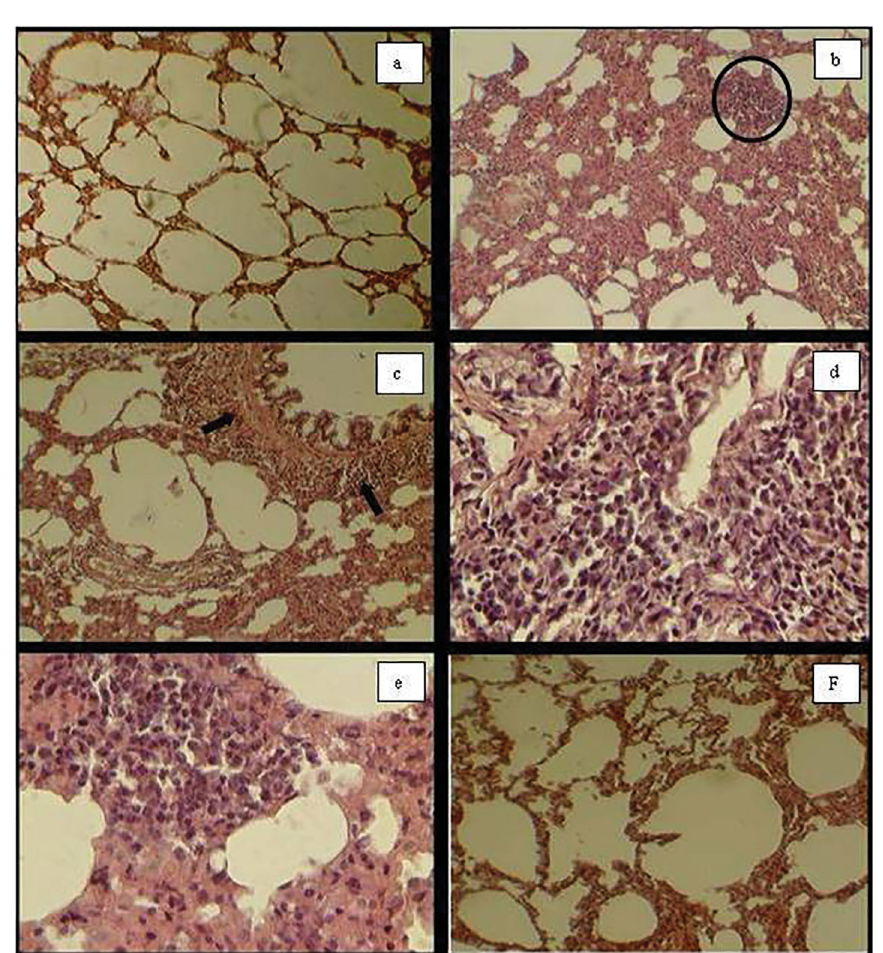
FIGURE 5 - The histopathological studies of lung sections viewed under a light microscope (hematoxylin and eosin [H&E] staining) in the control and experimental groups. (a) Control animals showing normal architecture with regular sized alveolar spaces (100× H&E) (b) and (c) Benzo(a)pyrene (B(a)P)-induced animals showing condensed architecture with destroyed alveoli, alveolar septal thickening, airway inflammation, and hyperchromatic nuclei in alveolar wall cells (100× H&E (d) and (e) higher magnification shows infiltration of inflammatory cells (400× H&E) (F) Propolis pre-treated cancer-bearing animals showing slightly reduced alveolar damage compared to that of control animals (100× H&E). Arrows indicate peribronchial inflammatory infiltration and circles indicate intense alveolar septal